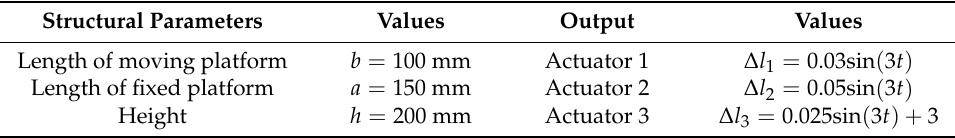
Table 1. Structural parameters of the 3-UPC type parallel prototype